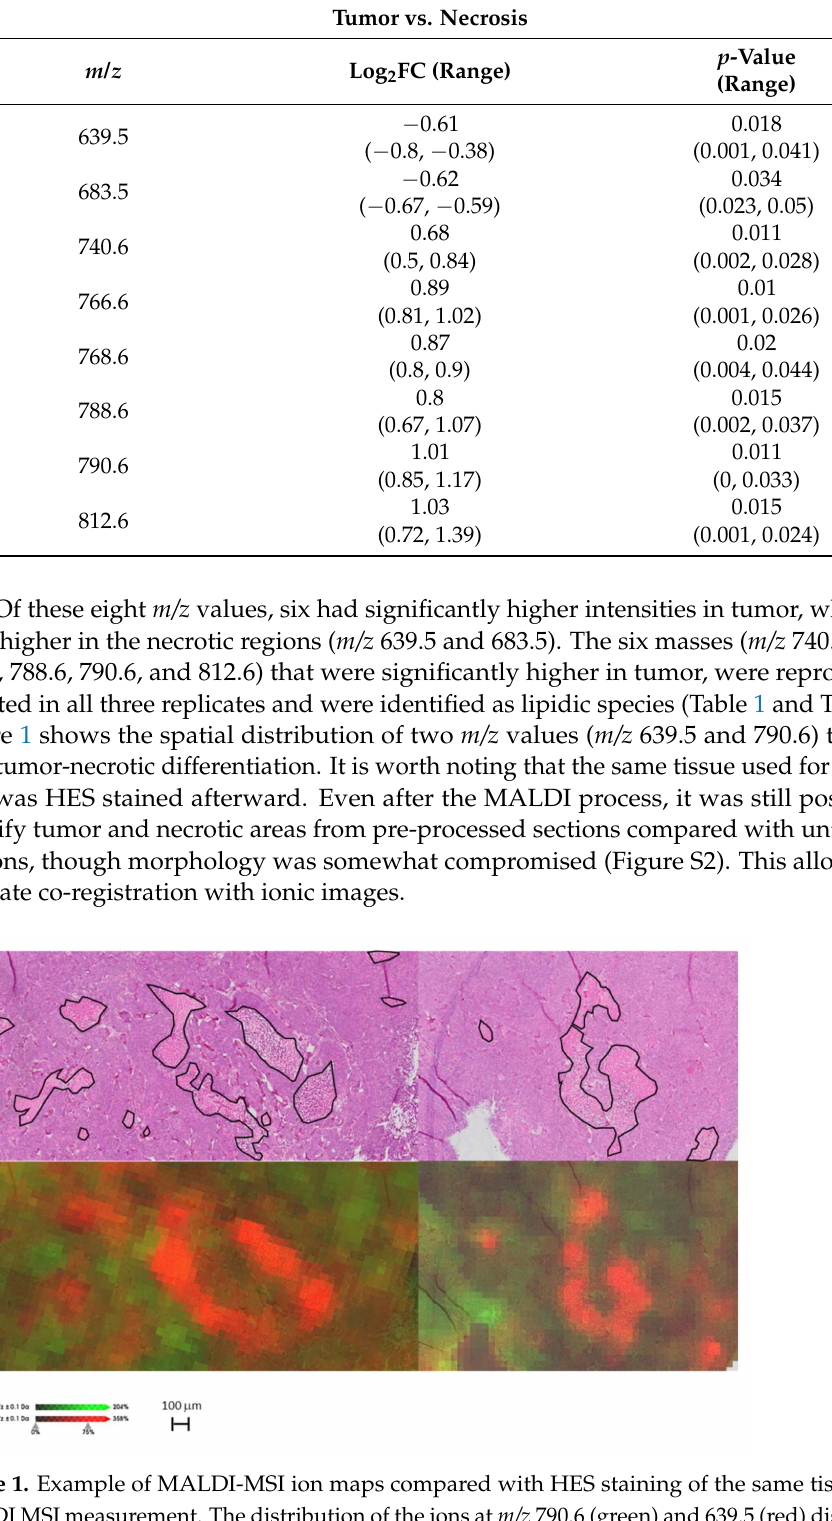
Table 2. Fold change and univariate linear mixed models testing comparing tumor and necrosis. Log 2 fold change (Log 2 FC) and p -values are the mean values across all three technical replicates. Masses that were significant (abs(log 2 FC) > 0.5, p < 0.05) in at least two replicates are presented. Positive log 2 FC indicates increase in tumor compared to necrosis.